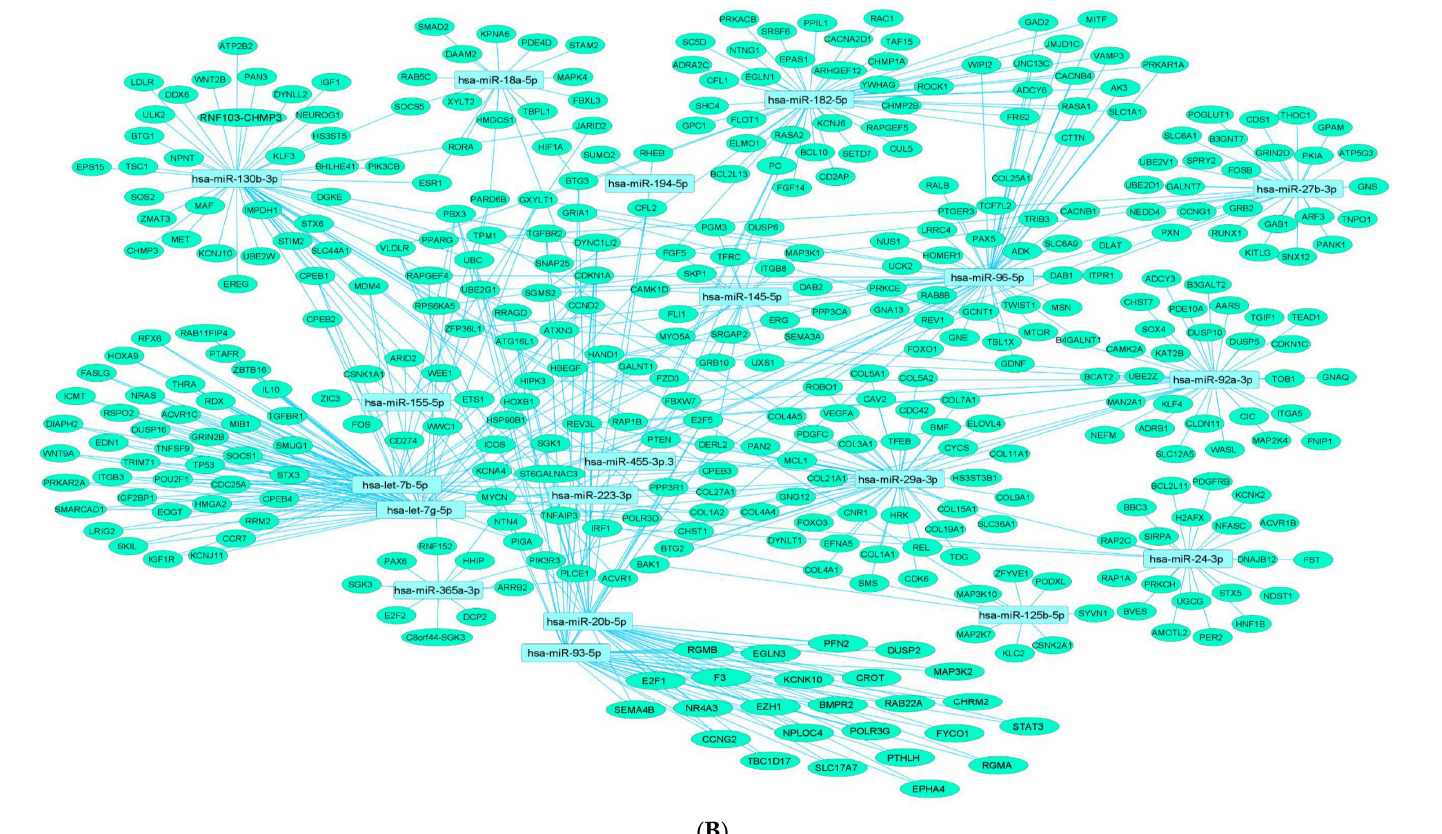
Figure 2. Downregulated human microRNA networks in diabetes: ( A ) Human microRNA–microRNA network: Human miRNA–miRNA interaction network with 74 nodes and 2701 edges. The networks were constructed using Cytoscape 3.9.1 [84]. ( B ) Human microRNA–gene target network: Architecture of networks of downregulated miRNAs implicated in diabetes in humans showing interaction network of functionally enriched miRNAs with their targets, with 417 nodes and 583 edges. The networks were constructed using Cytoscape 3.9.1 [84]. Using Mienturnet [85], the miRNA–target interactions were identified by TargetScan [86] and the functionally enriched miRNAs were generated using the KEGG database